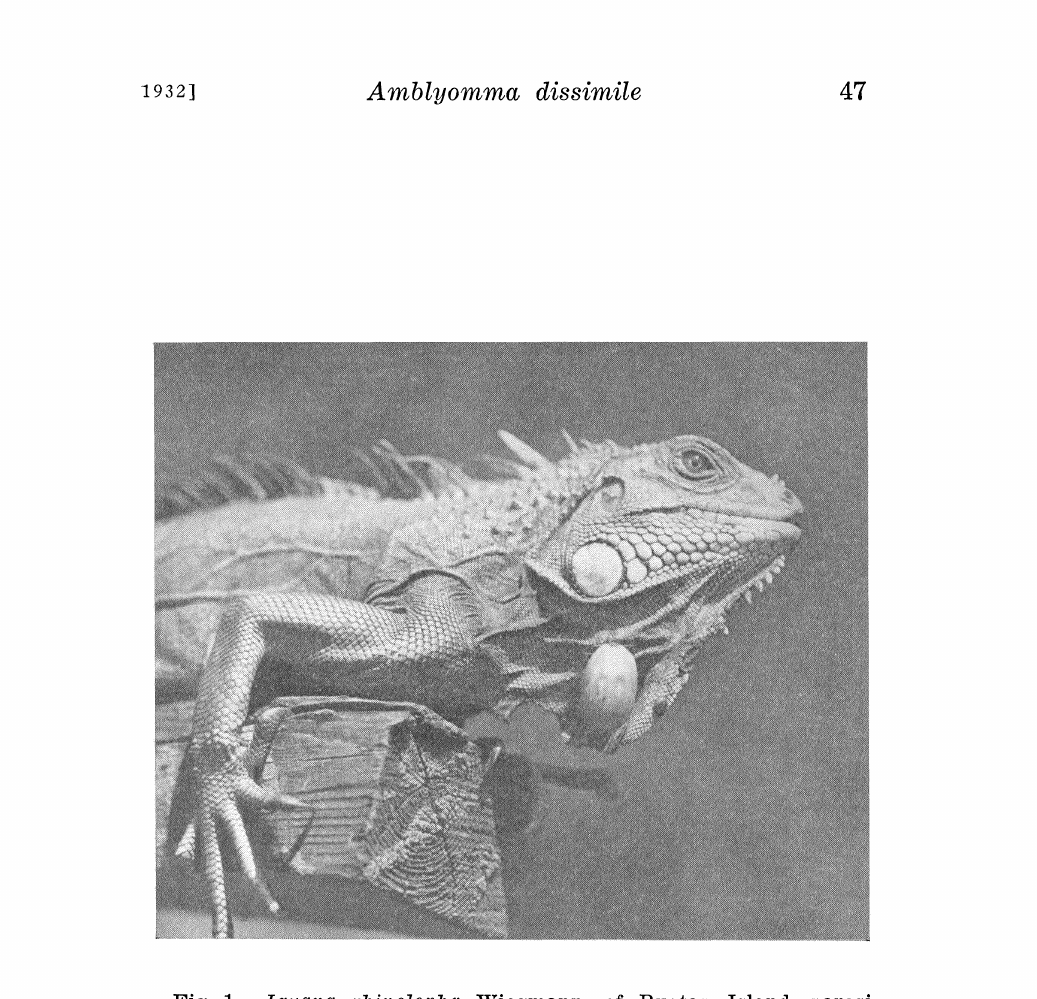
Fig. 1. Iguana rhinolopha Wiegmann, of Ruatan Island, parasi- tized by Amblyoma dissimile Koch. Photograph of living animal by Mr. G. Nelson. (Courtesy of Dr. Thomas